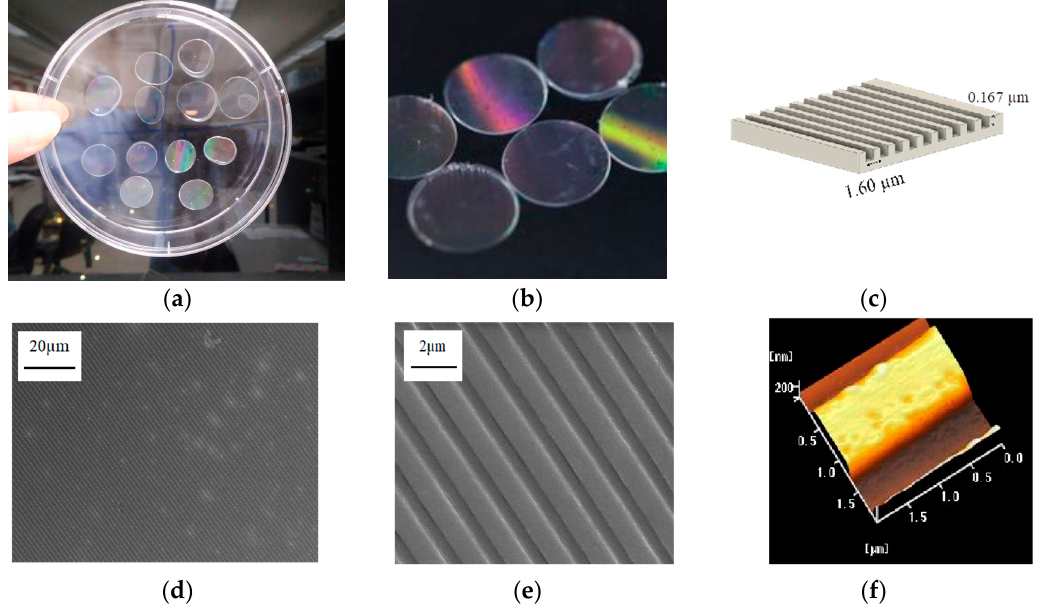
Figure 3. Production of the poly(ethylene-co-vinyl acetate) copolymer 2D scaffold. ( a ) The EVA scaffold was produced using a metallic stamper with a pitch of 1600 nm and a width of 740 nm to form a circular plate with a diameter of 12 mm; ( b ) the surface of the plate has a different reflective color; ( c ) schematic representation of the metallic stamper; ( d , e ) SEM images of the scaffold ( f ) AFM image of nanoimprinted topographical cell culture scaffold.